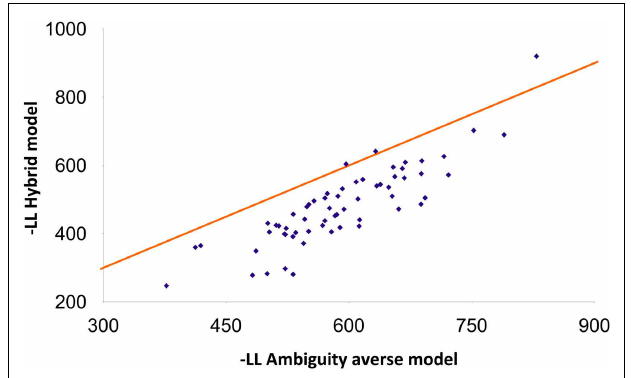
FIGURE 1 | Comparative fits of the ambiguity averse and hybrid models. The comparison of the fits is based on the negative log-likelihood (-LL) criterion. Each data point corresponds to one subject (500 samples on average per subject).The hybrid model fits better when the data point is below the 45˚